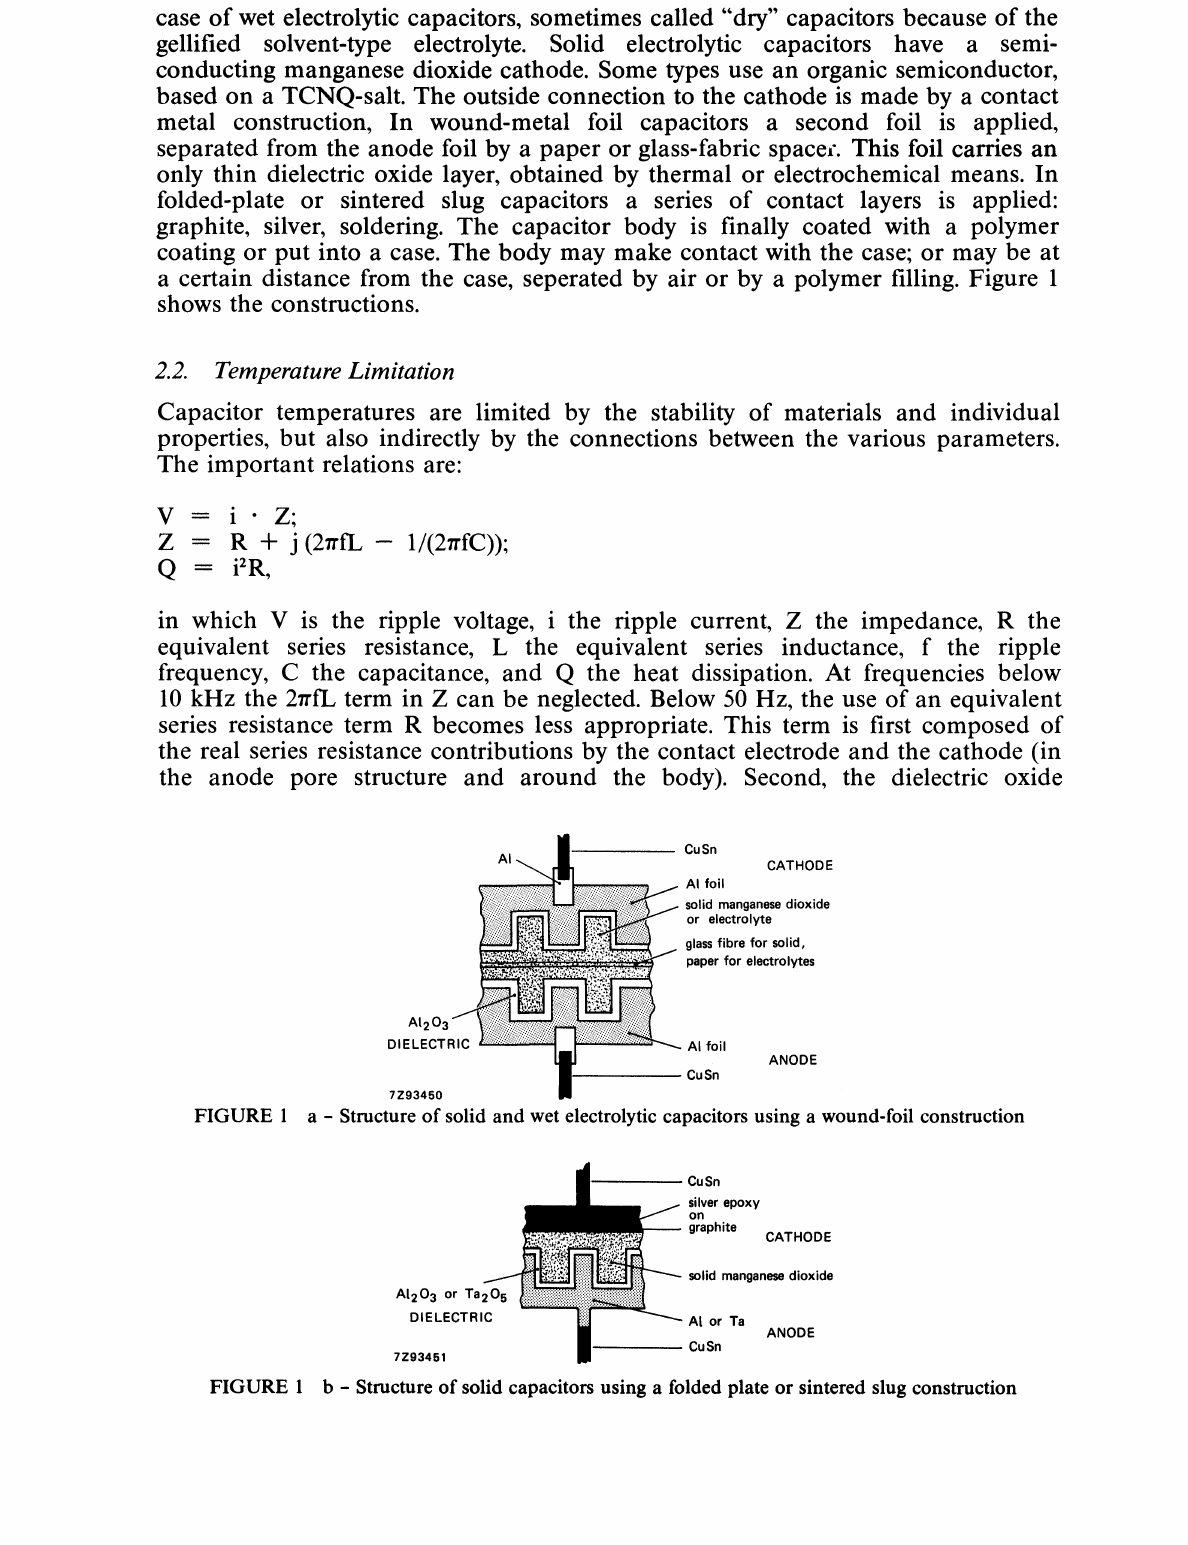
FIGURE b Structure of solid capacitors using a folded plate or sintered slug